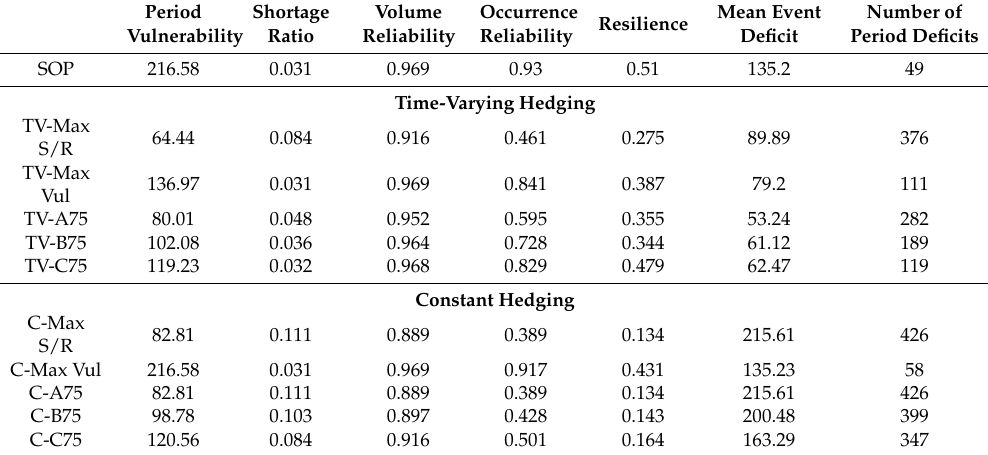
Table 4. Reservoir performance indices at 75% demand level for two point linear—a comparison of time-varying and constant hedging policies for selected compromising solutions (see figure 5).